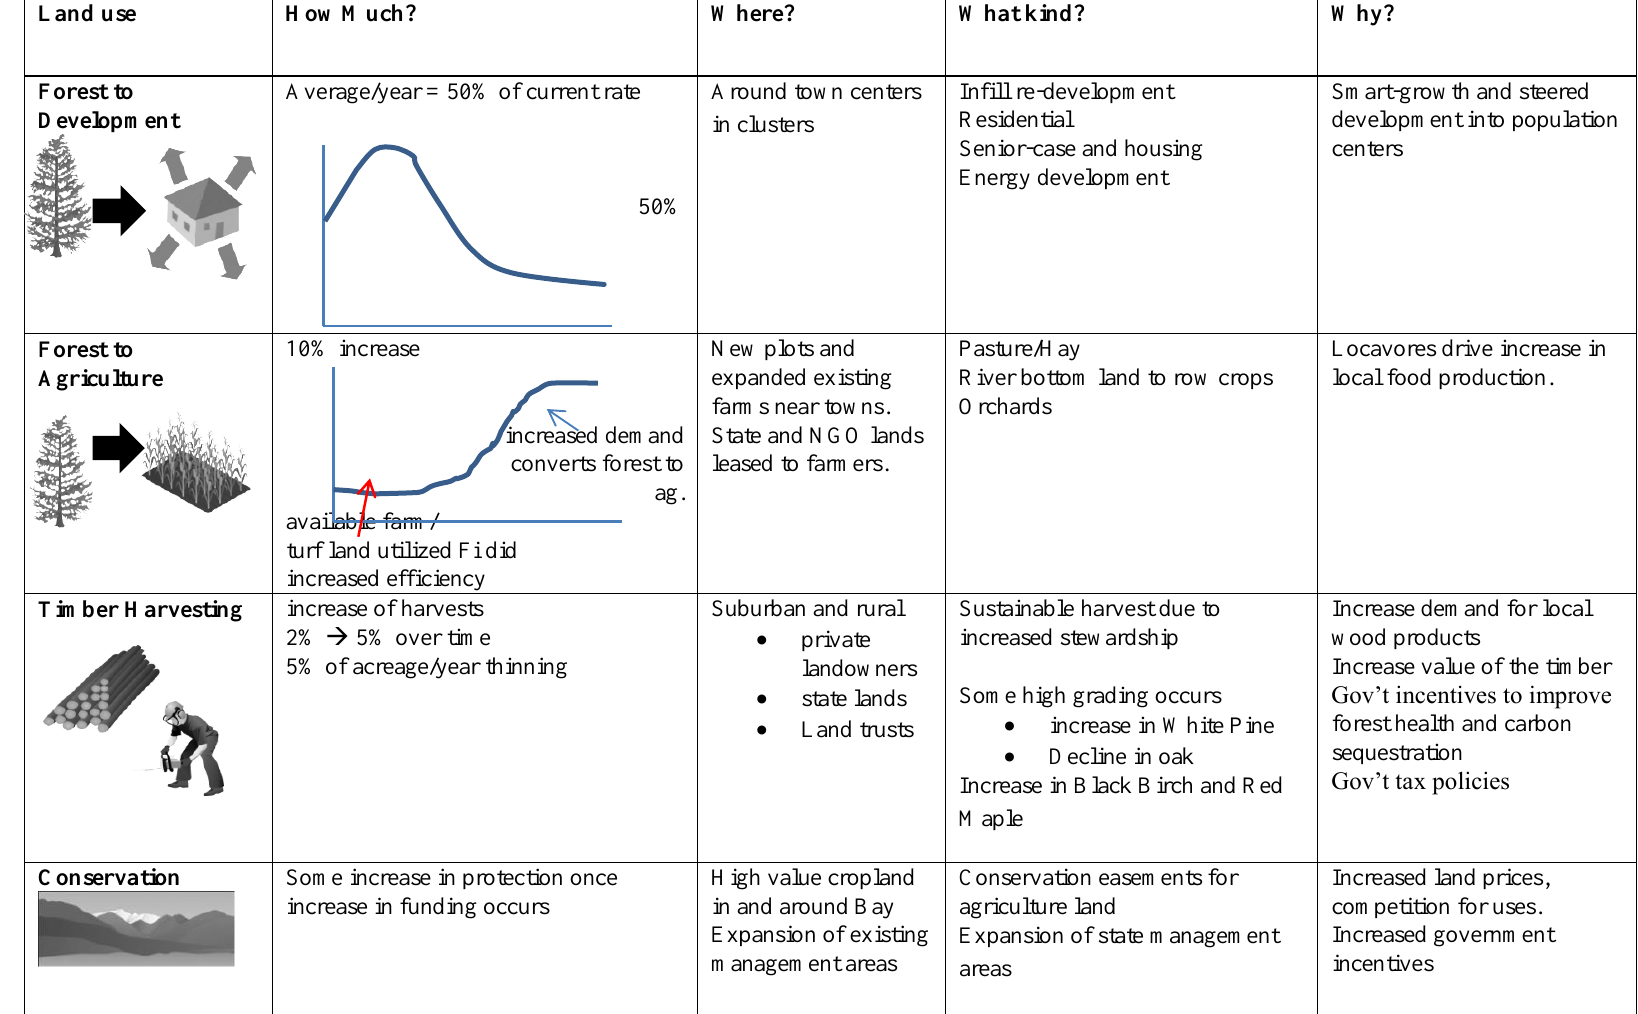
Table A2.18. Scenario 2: Shangri la: the impossible dream Land